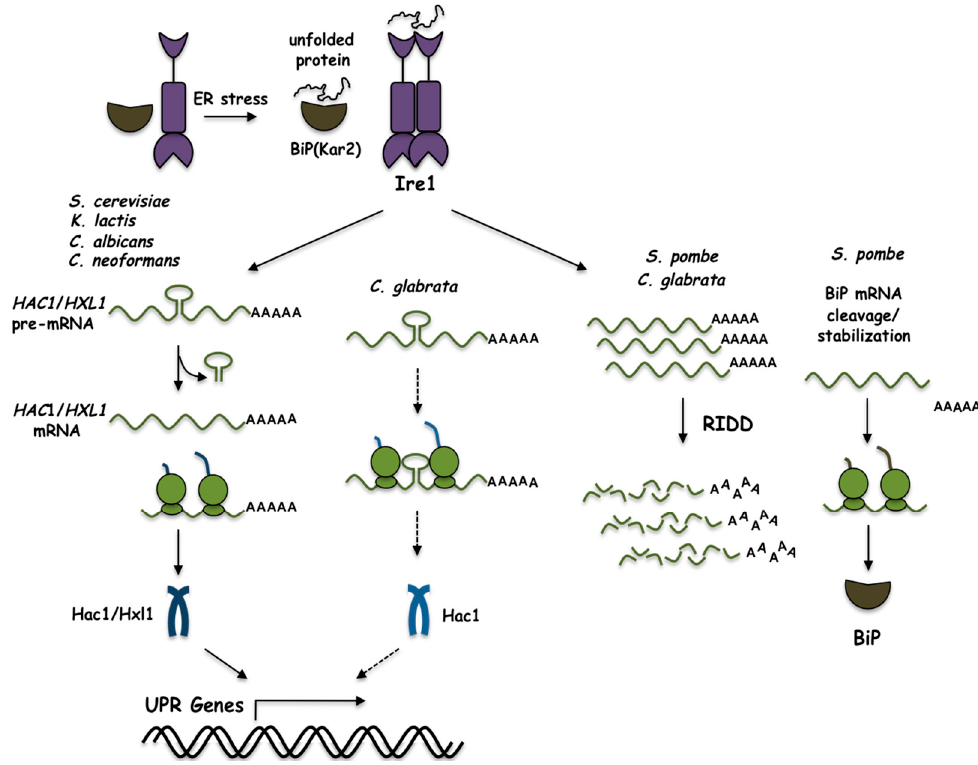
Figure 9. The unfolded protein response pathway in several yeast species. The accumulation of unfolded proteins in the ER leads to the activation of Ire1. In Sc ., Kl ., Ca. , and Cn ., Ire1 splices the HAC1 / HXL1 pre-mRNA leading to its translation. The synthesised bZIP factor (Hac1/Hxl1), regulates transcription of UPR-responsive genes. In Sp ., and Cg ., Ire1 cleaves ER-localised mRNAs through the Regulated Ire-Dependent Decay (RIDD) pathway. In Sp ., Ire1 also cleaves the BiP mRNA in the 3 ′ UTR region leading to its stabilization and translation. As described in the text, the unspliced HAC1 RNA of Cg may induce transcription of UPR-responsive genes in S. cerevisiae (depicted by the dotted arrows), although there is no evidence that this process can actually occur in C. glabrata .